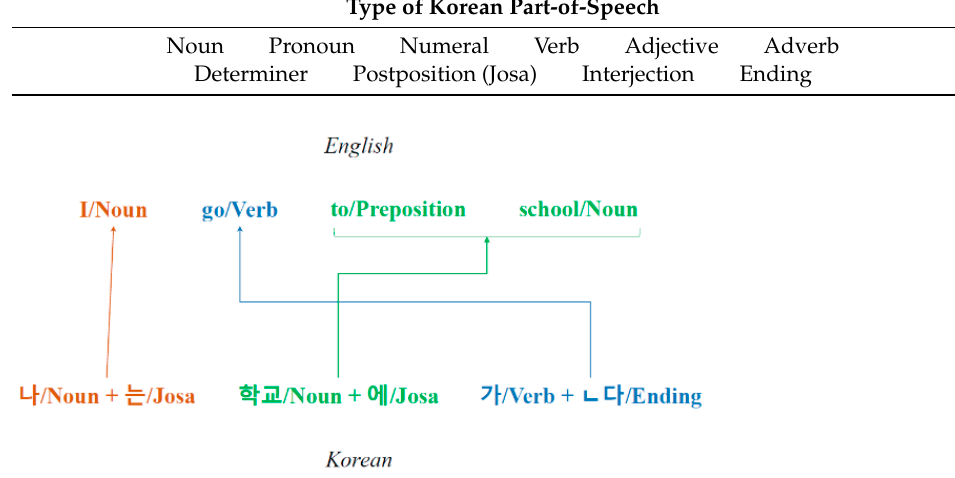
Figure 2. Example of part-of-speech system of Korean and English. Table 4. Korean part-of-speech